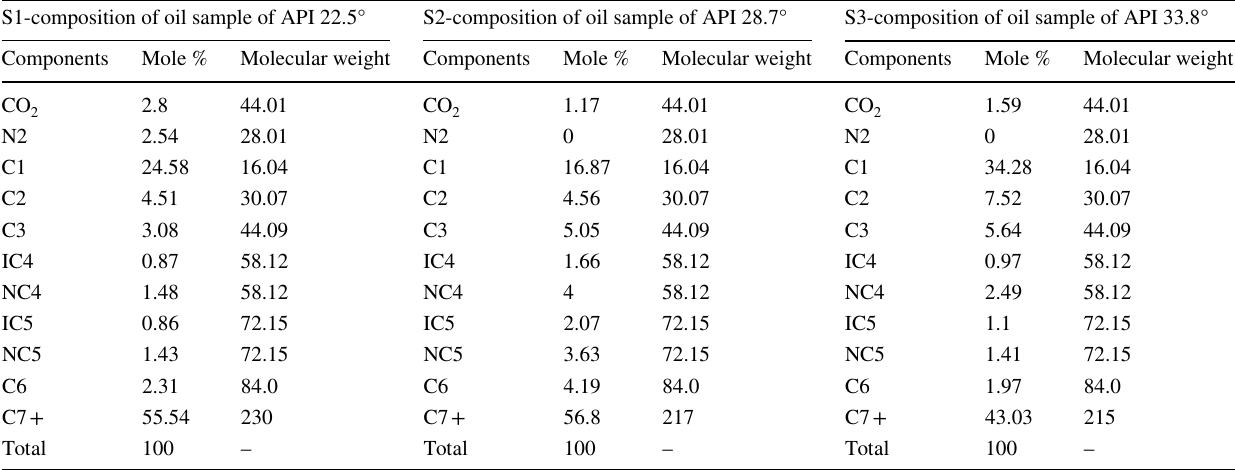
Table 1 Compositional analysis of three oil samples S1-composition of oil sample of API